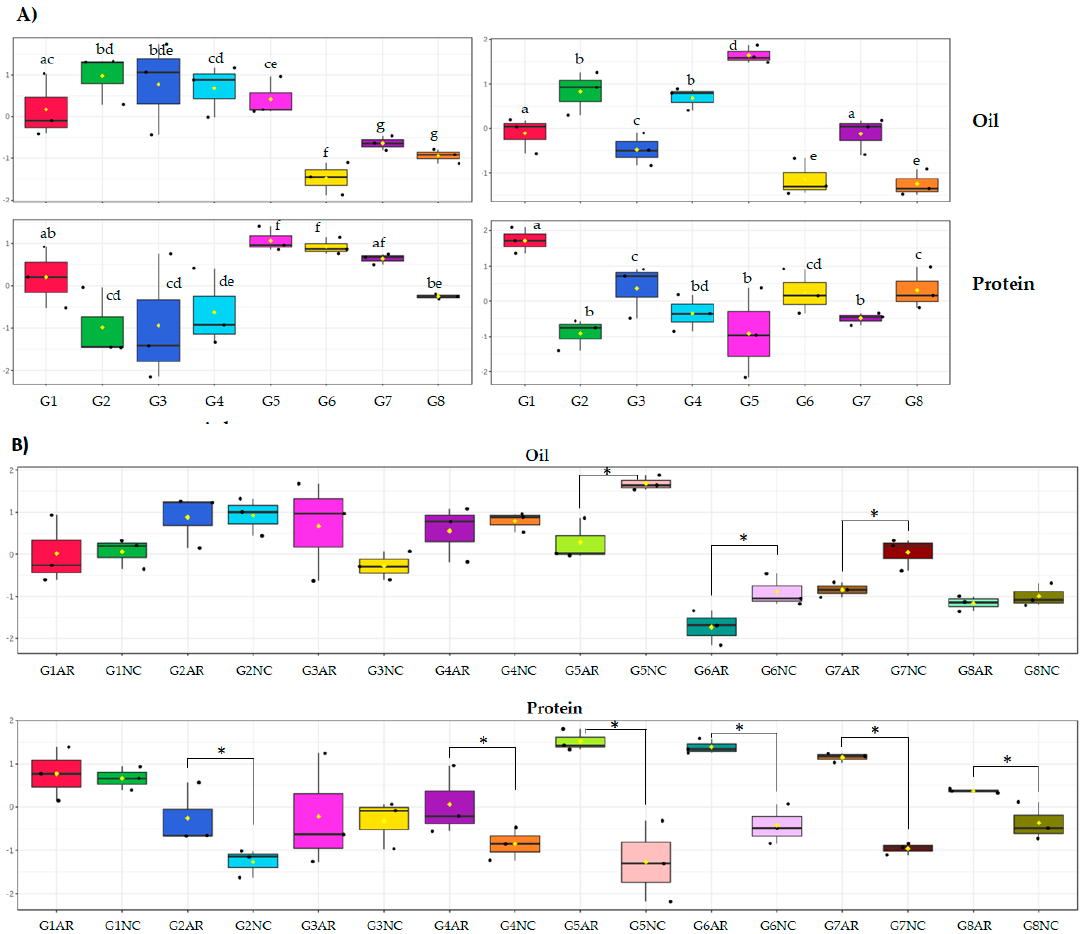
Figure 2. Oil and protein content in the eight soybean genotypes (G1 to G8) cultivated in two di ff erent locations (Arkansas, AR, and North Carolina, NC). The percentages were log-transformed and auto-scaled using MetaboAnalyst software for better visualization. ( A ) Comparison at each location and ( B ) comparison across locations. The di ff erences in oil content between locations of the three genotypes that were significantly di ff erent ranged between 0.9 and 1.8%, while the di ff erences in protein content between locations of the six genotypes that were significantly di ff erent ranged between 1.6 and 6.3%. Significant di ff erences are noted with letters or asterisks in A and B, respectively (ANOVA, Fisher LSD, p < 0.05, n = 3).